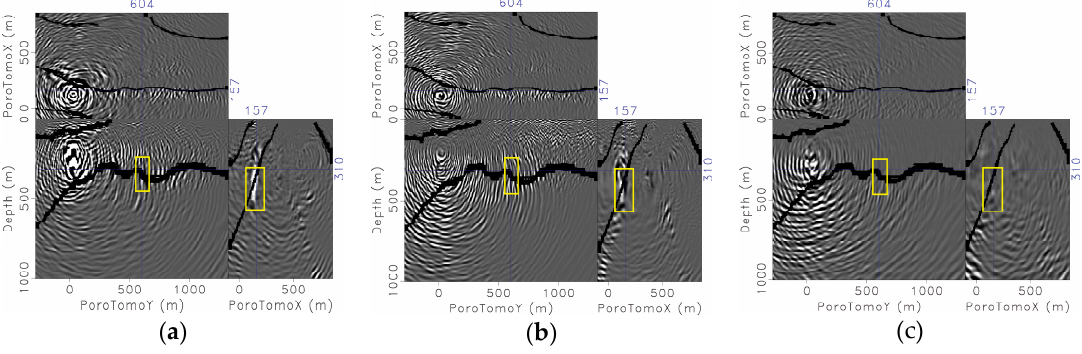
Figure 8. Middle West-dipping Fault. Kinematics: P-wave Velocity Down & S-wave Velocity Up (P–S image) of ( a ) Wr = synthetic 4 fault model, ( b ) Wr = Field Brady’s field data ( c ) Wr = Pure Noise